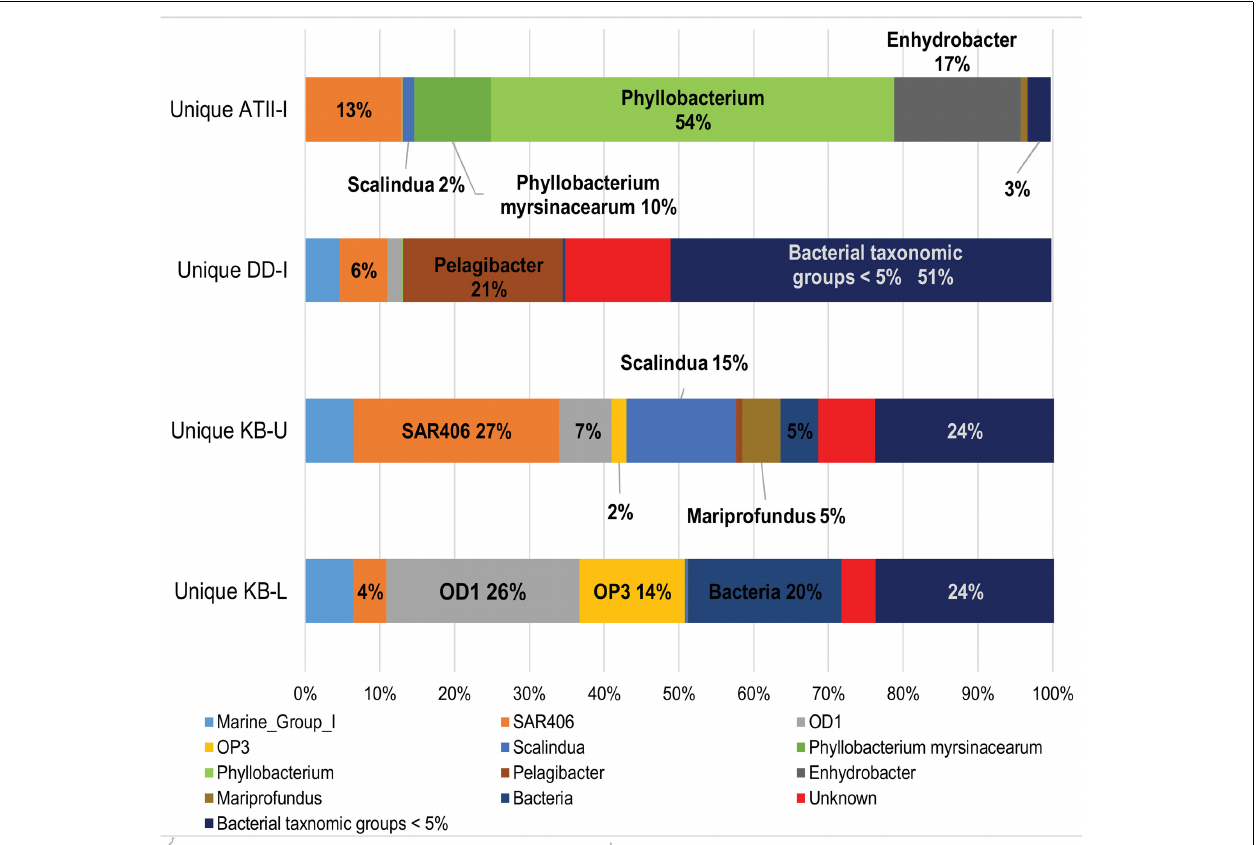
FIGURE 2 | Assignment of unique 16S rRNA sequences from the brine-seawater interface to major bacterial taxonomic groups. Representation of the significant unique 16S rRNA OTUs obtained at the interfaces assigned to major bacterial taxonomic groups in the four brine-seawater interface layers. The graph is based on VAMPS taxonomic classification of statistically significant reads after subtracting 16S rRNA